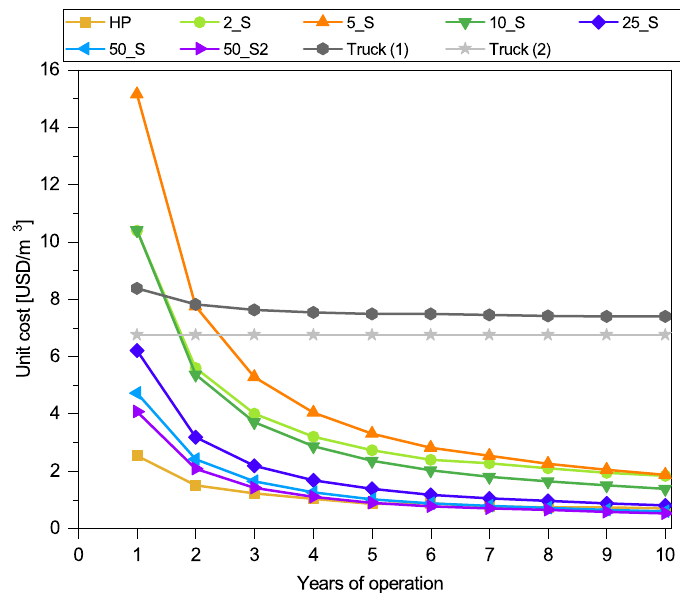
Figure 5. Overview of unit costs (USD/m 3 ) for the assessed alternatives: solar-powered system (running for 7 h), hand pump and water trucking. Details in Supplementary Material A.16. For a list of the alternatives, see Table 3. Discount rate = 0%.